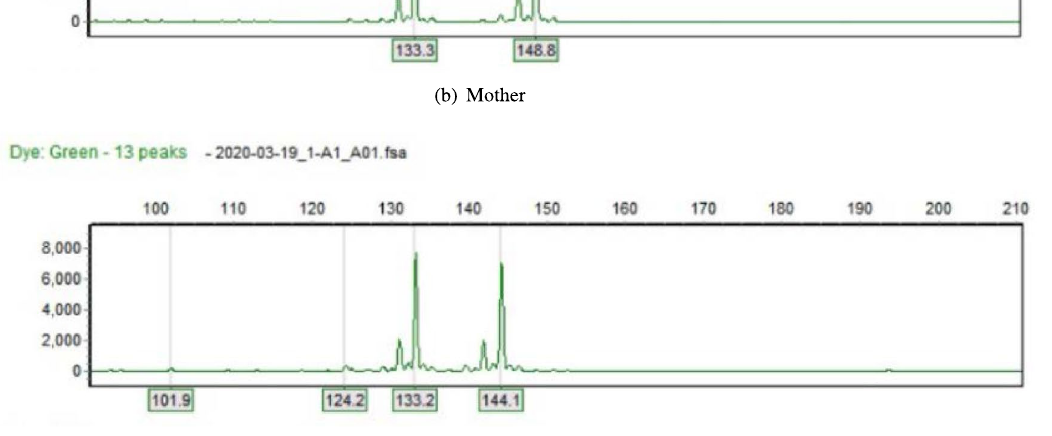
these three crosses are true hybrids and can be identified by at least two pairs of primers.